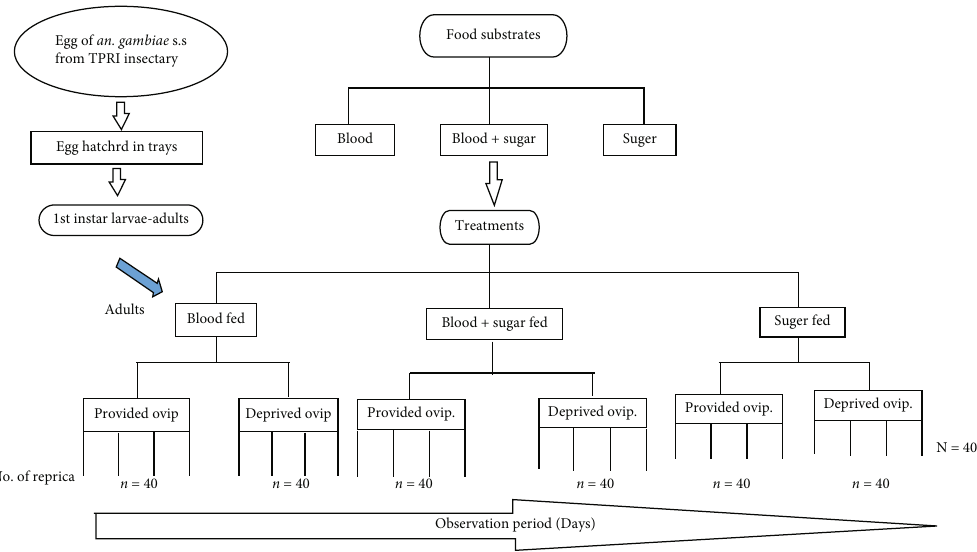
Figure 1: Summary of the experimental study